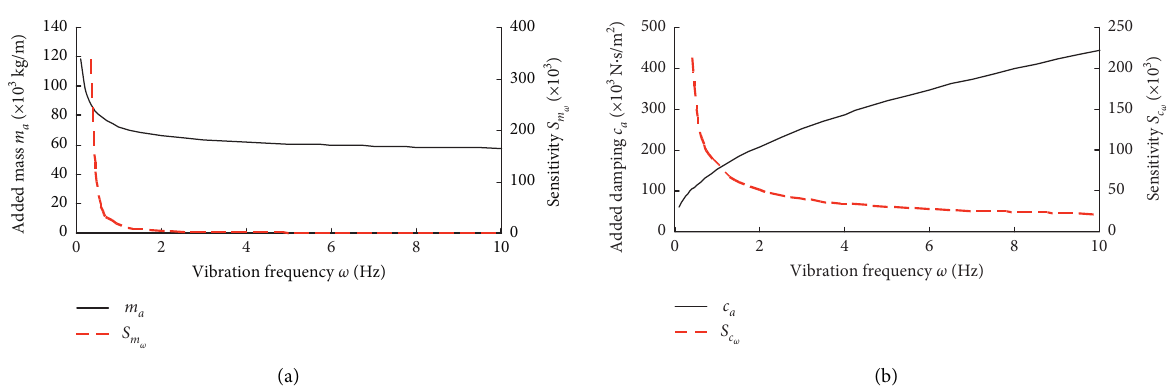
Figure 5: Influence of vibration frequency on the added mass (a) and added damping (b).